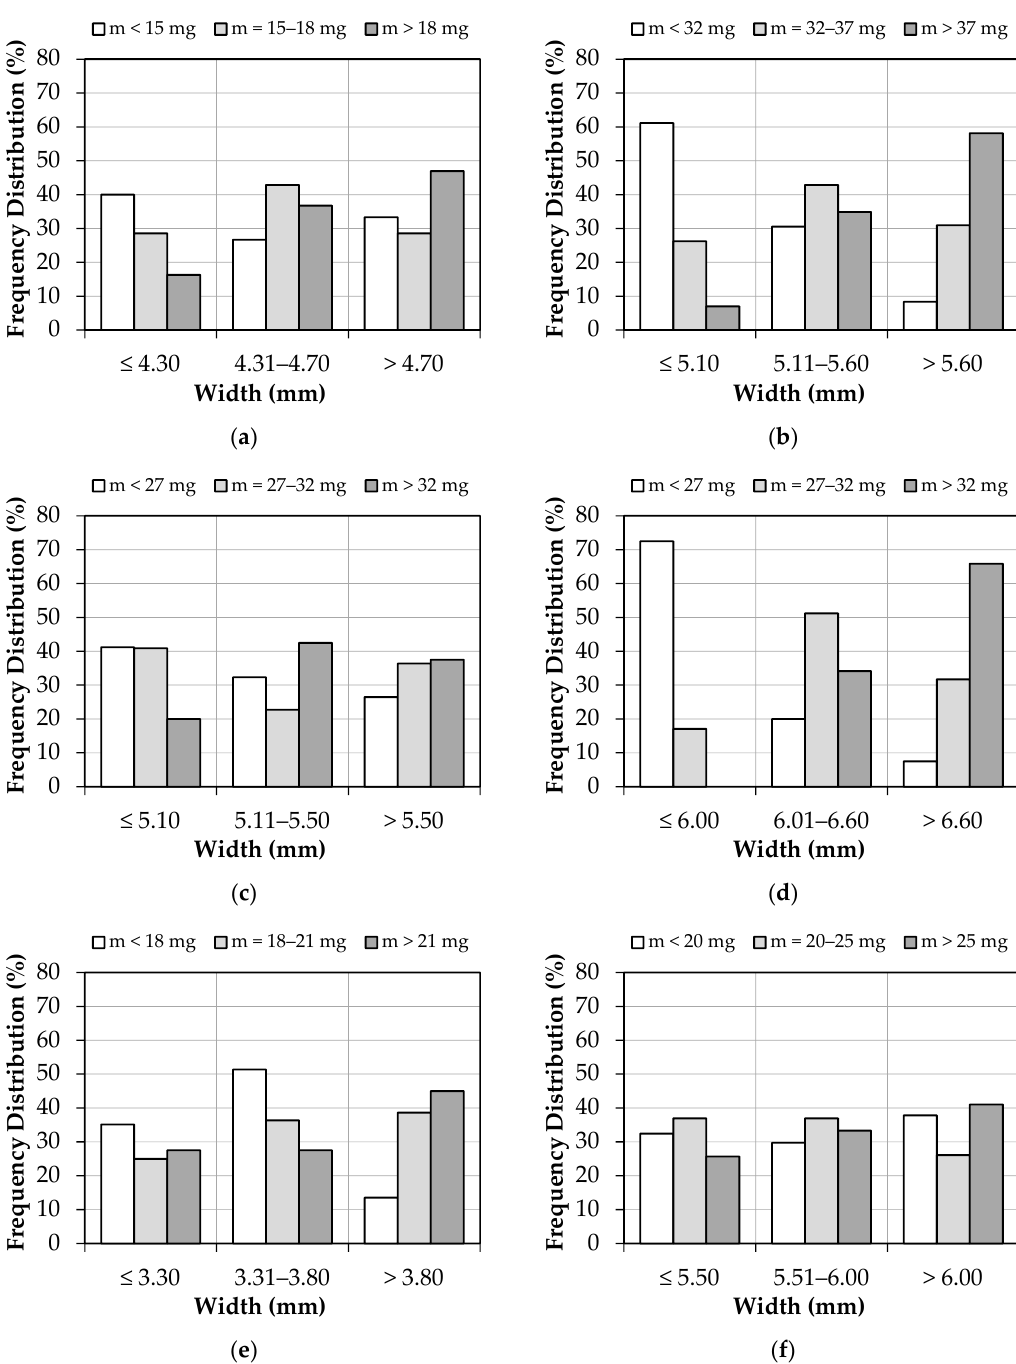
Figure 4. Distribution of seed width in the analyzed Viburnum species: ( a ) V. dasyanthum ; ( b ) V. lantana ; ( c ) V. lentago ; ( d ) V. opulus ; ( e ) V. rhytodophyllum ; ( f ) V. sargentii .